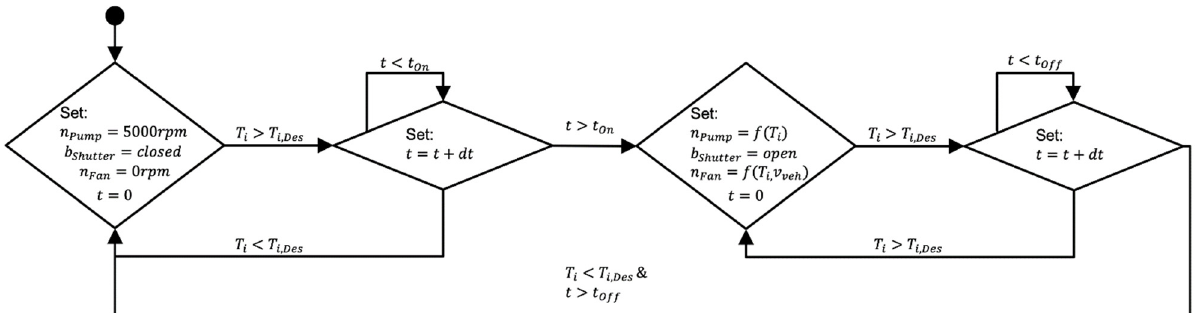
Figure 8. Simplified logic of rule-based controller for pump and fan speed as well as for shutter position depending on vehicle velocity and component temperatures.